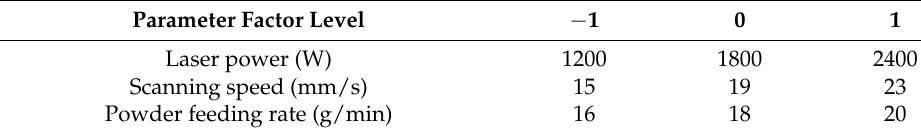
Table 4. Cladding parameters and coding level table.